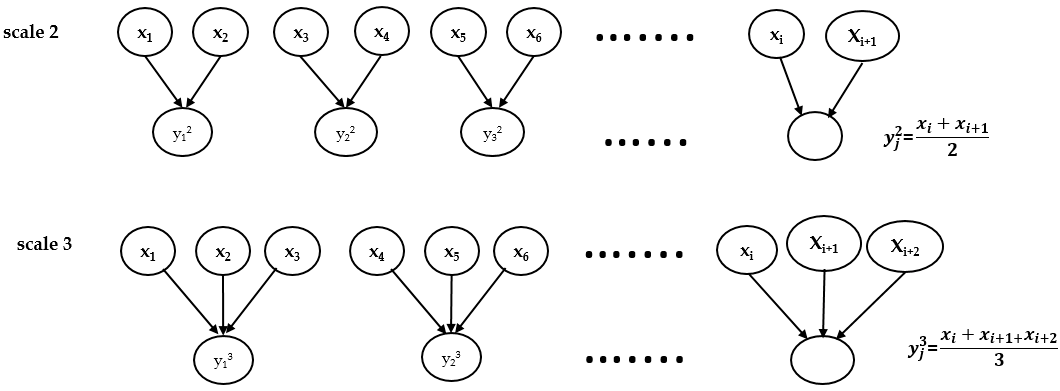
Figure 2. The schematic diagram of a coarse-grained procedure for scales two and three. Figure reproduced from Ref.